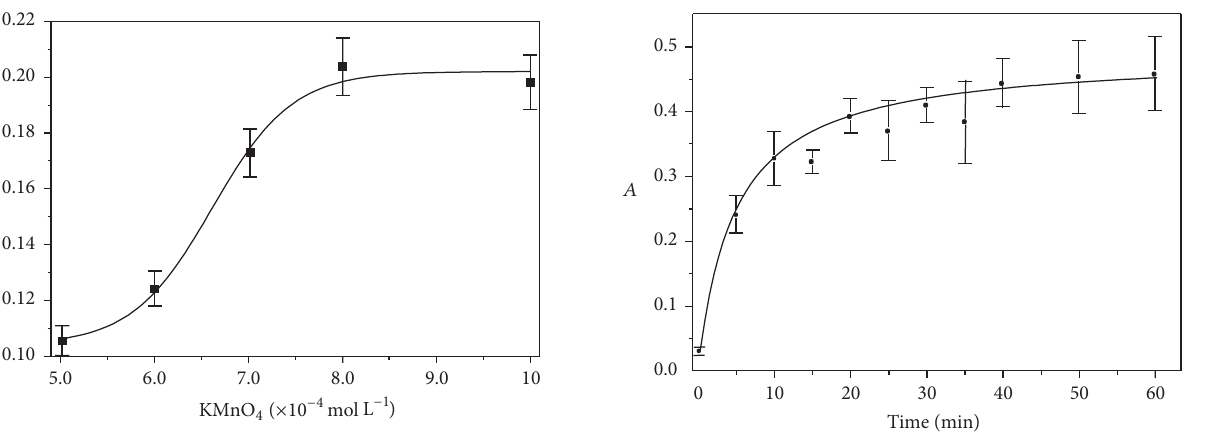
Figure 5: Effect of reaction time ( t ) on the AOF-KMnO 4 system, at NaOH 0.34 mol L −1 , AOF 2.3 × 10 −5 molL −1 , KMnO 4 9.0 × 10 −4 mol L −1 , NaOH 0.30 mol L −1 , Na 2 SO 4 0.20 molL −1 , T ∘ = 50 ∘ C, and monitoring at 610